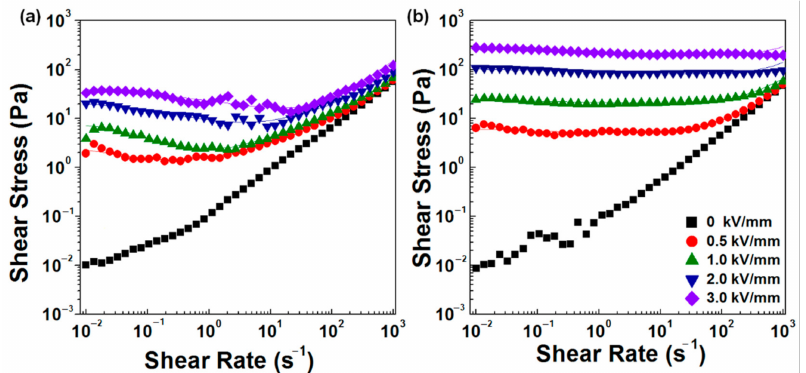
Figure 4. Shear stress curves of the ER fluids of cellulose ( a ) and cellulose/Laponite composite particles ( b ) at various electric field strengths. The solid lines are fitted from the CCJ model.